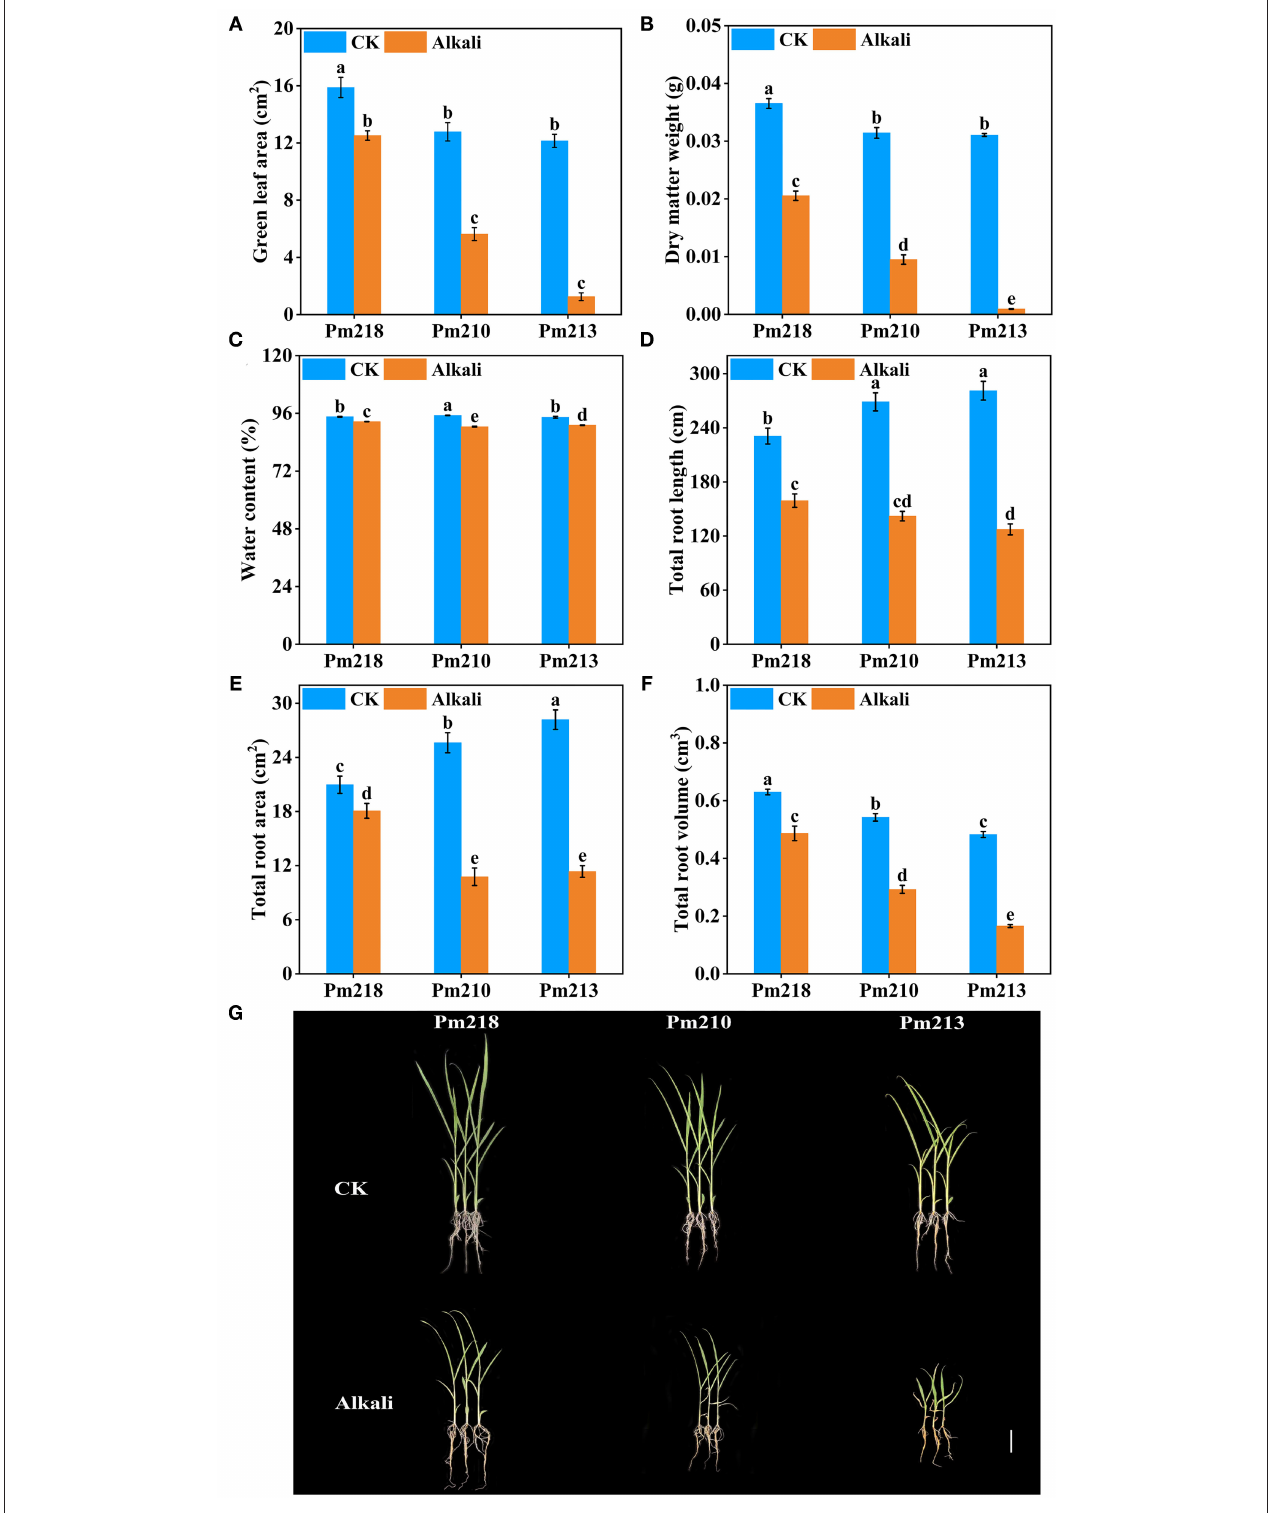
FIGURE 4 | Growth characteristics of three genotypes under control (CK) and alkali stress in the seedling stage. (A) green leaf area; (B) dry matter weight; (C) water content; (D) total root length; (E) total root surface area; (F) total root volume. (G) Growth status of alkali-tolerant variety (Pm 218), moderate alkali-tolerant variety (Pm 210), and alkali-sensitive variety (Pm 213) under control (CK) and alkali stress. Bar = 5cm. Different letters indicate significant differences ( P < 0.05).